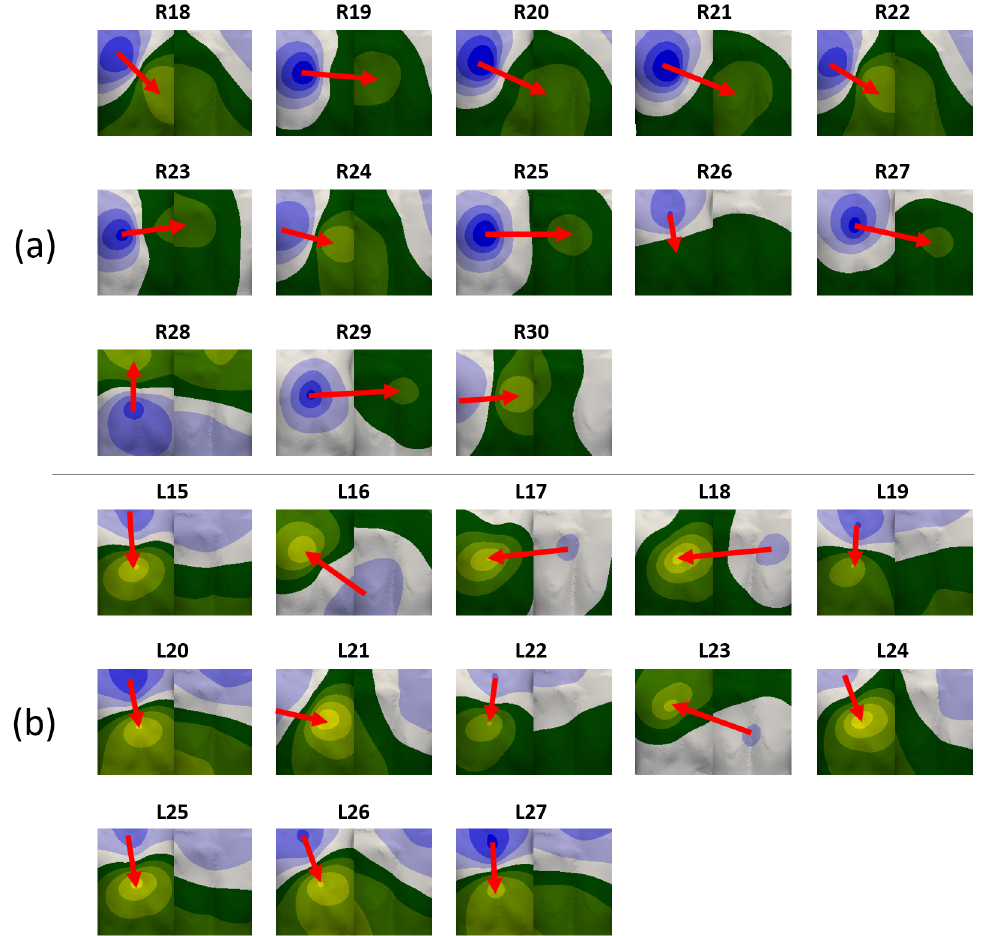
Fig 6. Simulated normalized body surfaceP-wave integral maps (BSPiM). BSPiMs have been computedat the torso surface for the 26 additionalectopic foci stimulatedat a) RA (R18 to R30), and b) LA (L15 to L27). Normalization was carried out basedon the maximum range of P-wave integralconsideringthe 58 different BSPiMs.